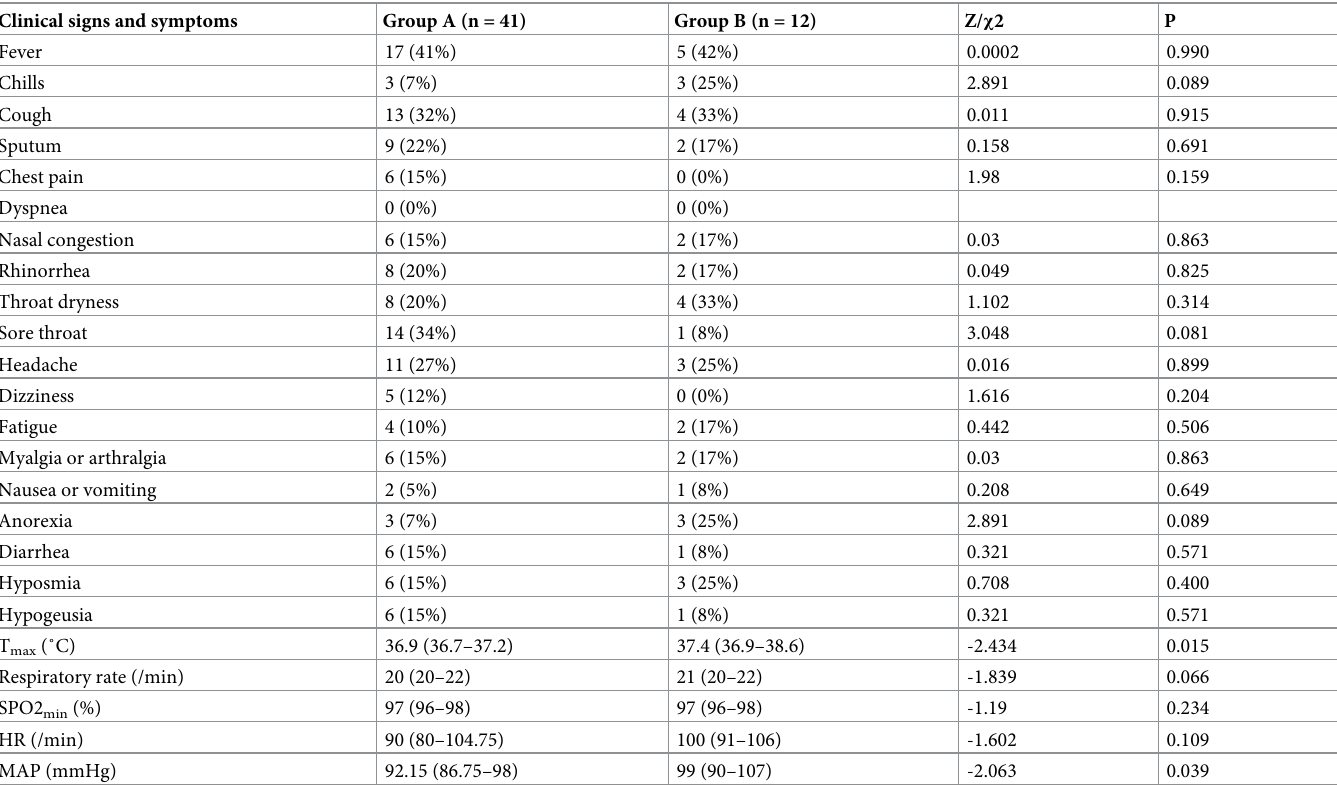
Table 2. Clinical symptoms and body signs of the two